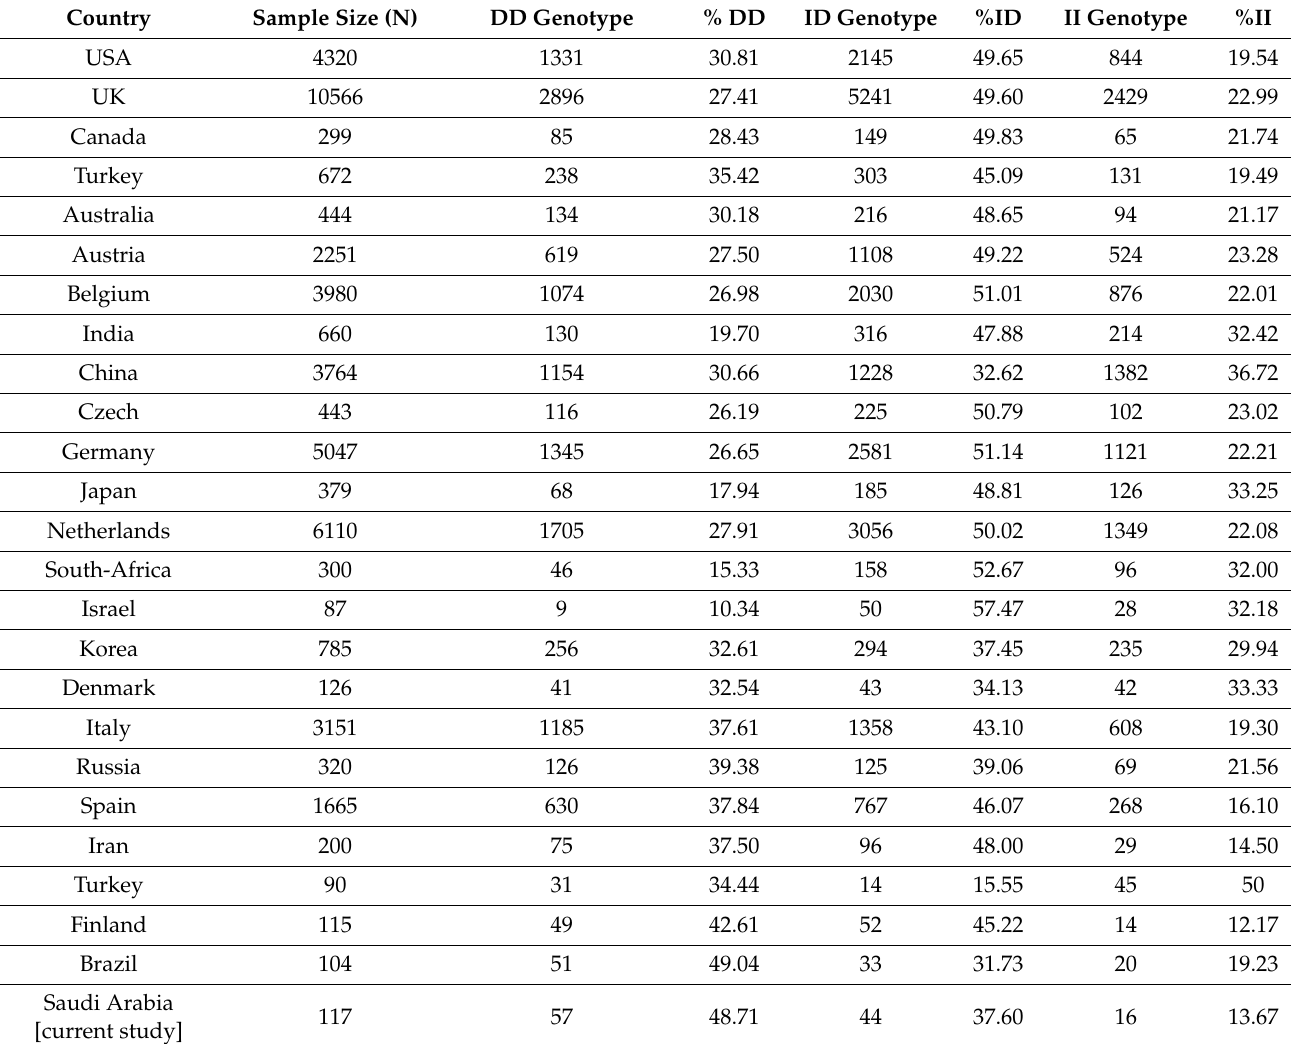
Table 13. Distribution of ACE2- II, DI and DD genotypes in the SARS-CoV-2 patients in the world populations.